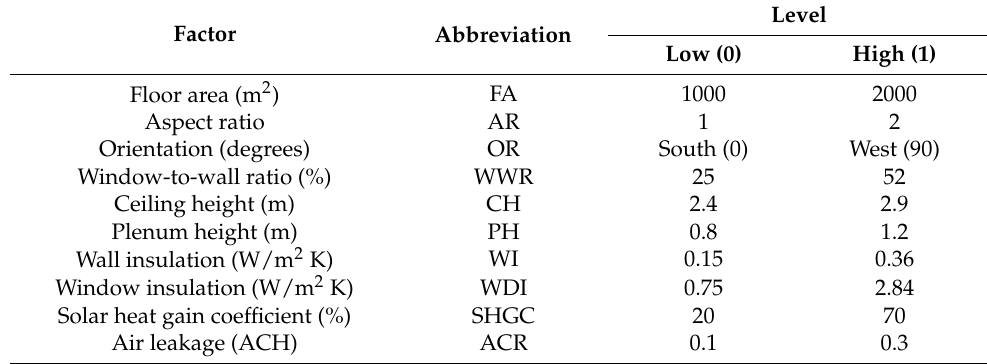
Table 3. List of factors and their